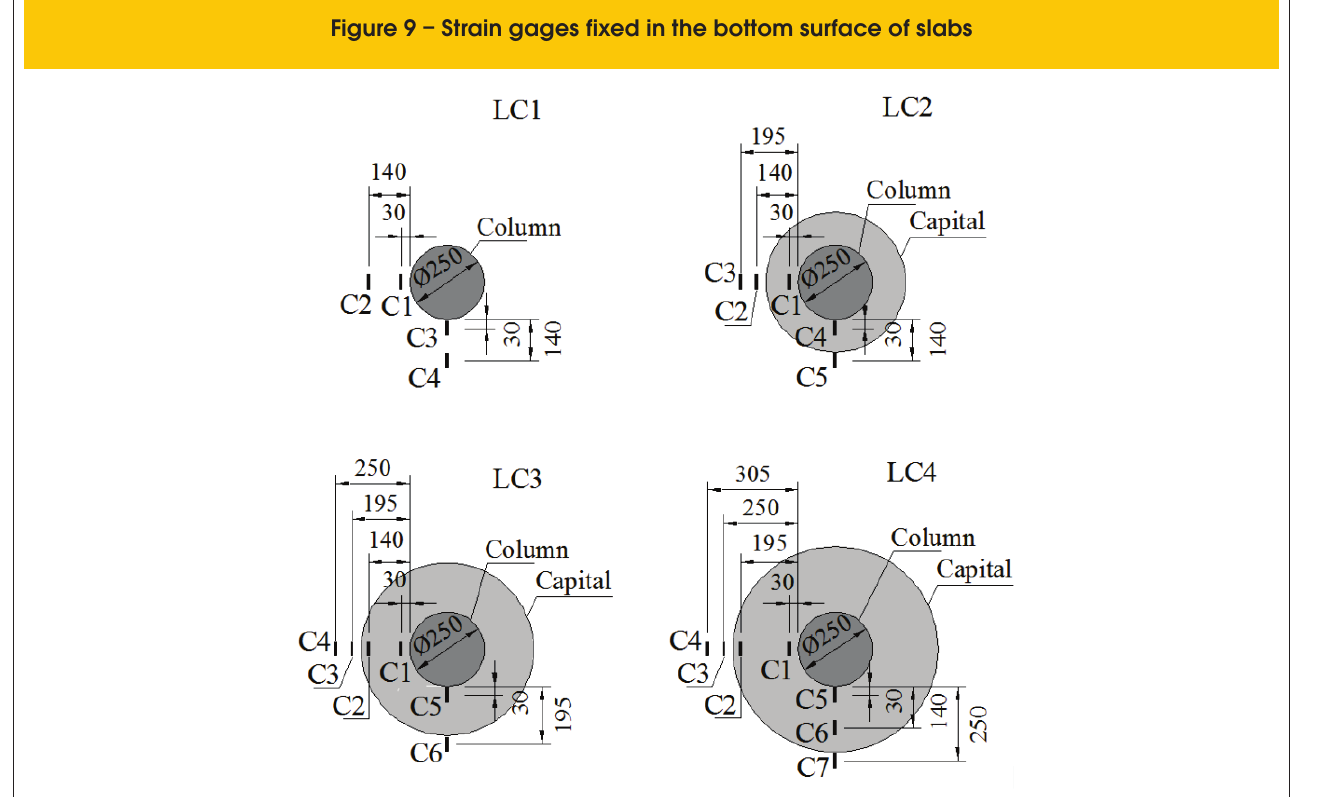
Figure 9 – Strain gages fixed in the bottom surface of